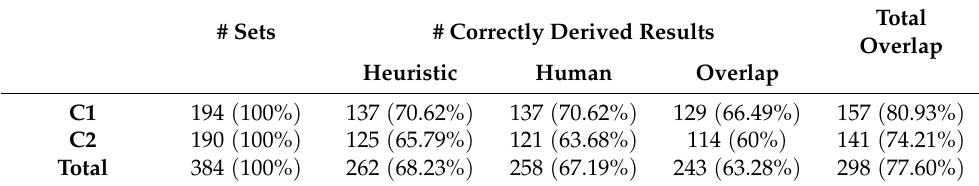
Table 7. Comparative analysis (C1—Corpus 1; C2—Corpus